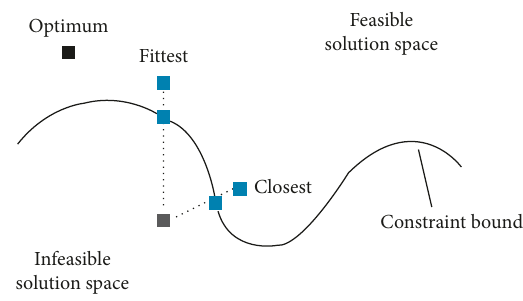
Figure 2: Repair of an infeasible solution